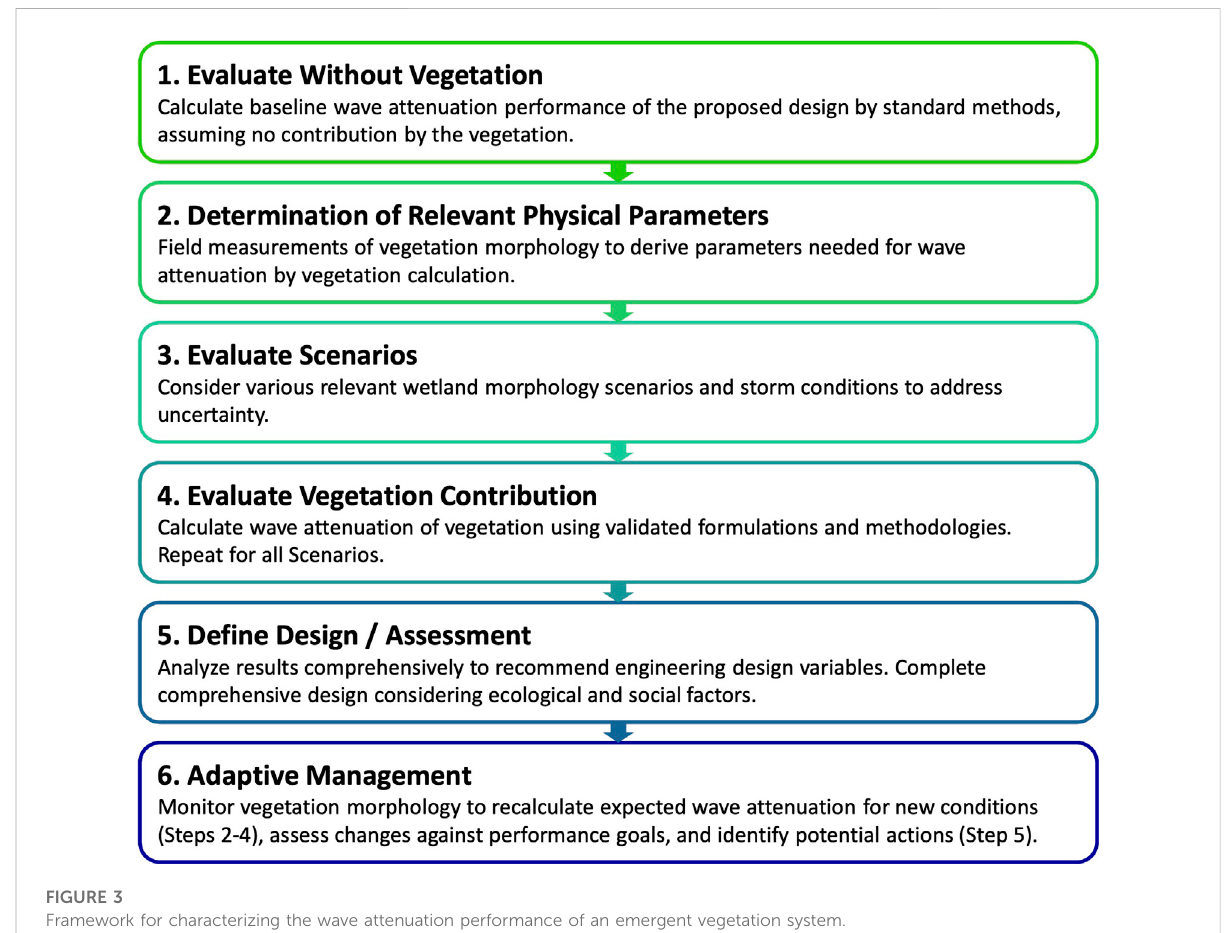
FIGURE 3 Framework for characterizing the wave attenuation performance of an emergent vegetation